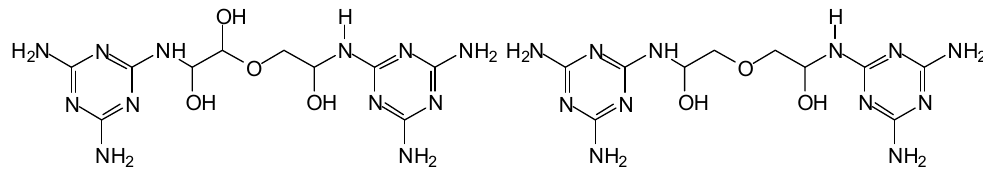
Figure 8. FTIR spectra of IL, MG+IL resin and MGG’+IL resin.